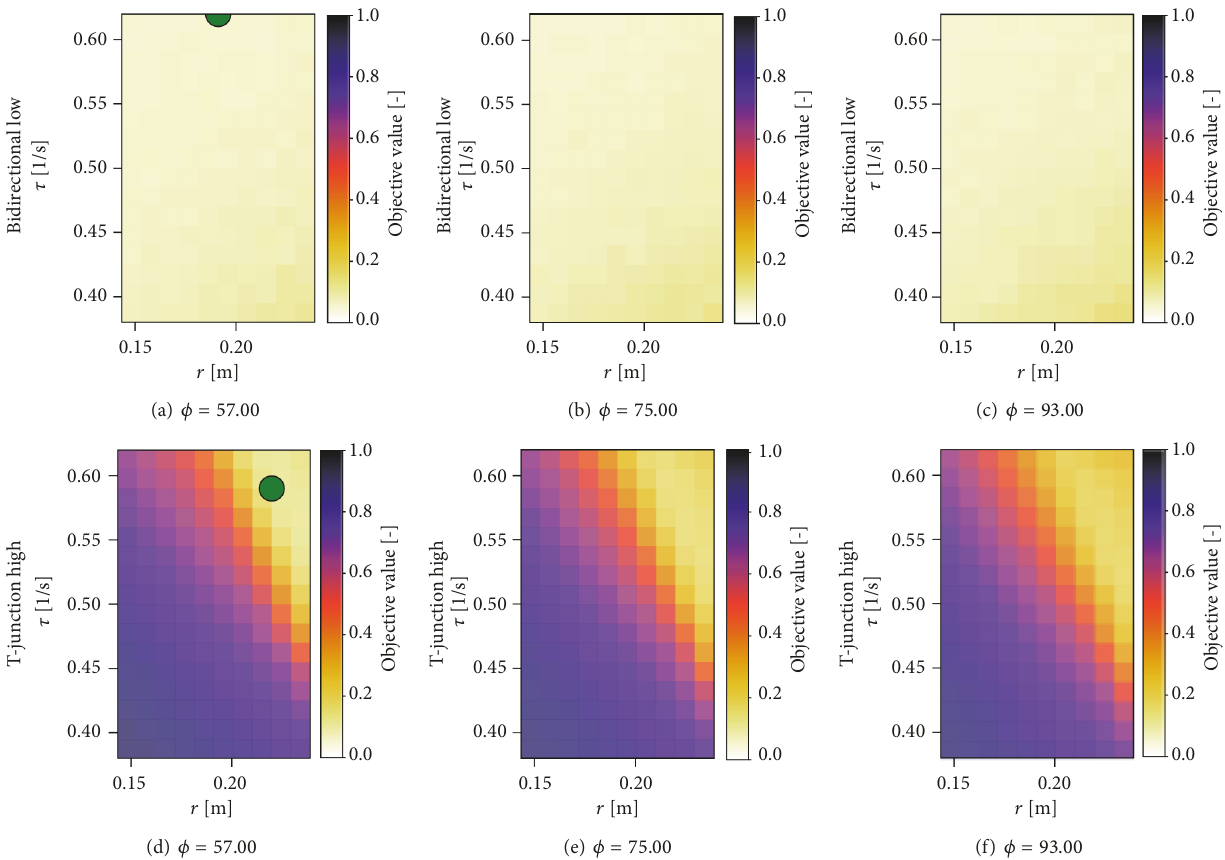
Figure 7: Examples of surface plots showing how the objective value changes over the search space. The green dot identifies the location of the optimal parameter set.